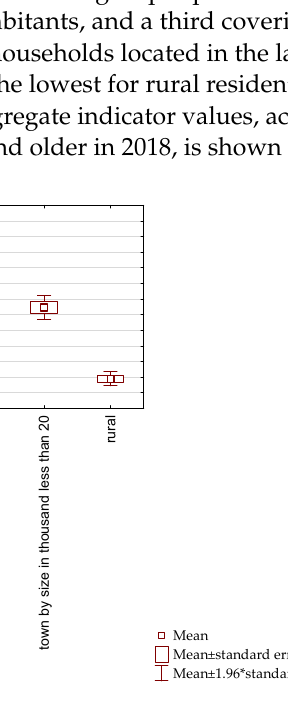
Figure 6. The level of the aggregate indicator in 2018 by household location for households of people aged 60 and older. Source: own elaboration based on data from [136].